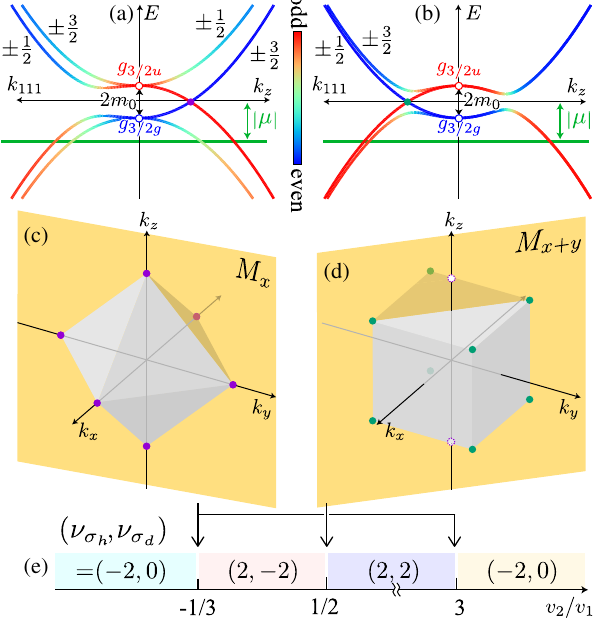
FIG. 1. Energy dispersion near the Γ point for (a) v 2 ¼ 3 v 1 and k (b) v 2 ¼ v 1 = 2 . The dispersions along k and k 111 ¼ ð k ffiffiffi z x þ y þ p 3 = k are labeled by the z and (111) component of angular z Þ momenta j and j 111 , respectively. For the hole-doped antiper- z ovskite material Sr 3 − SnO, the Fermi level is located below the x fourfold degeneracy point E ¼ − m 0 as indicated by the green line. (c) and (d) show the octahedral and cubic Dirac points for v 2 ¼ 3 v 1 and v 2 ¼ v 1 = 2 , respectively. The dots denote the Dirac points. The transparent panels indicate the mirror plane defining the topological phase transition with the creation of the Dirac points. (e) shows the horizontal and diagonal mirror Chern numbers ν σ and ν σ as a function of v 2 =v 1 h d